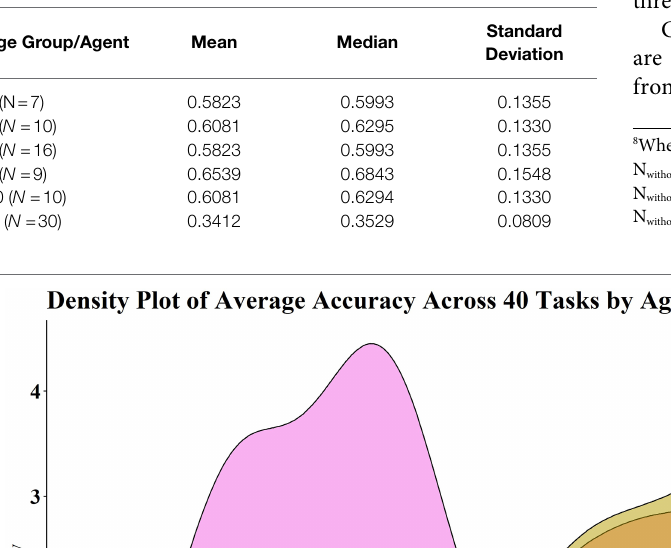
TABLE 4 | Measures of central tendency and deviation by age group/agent type.